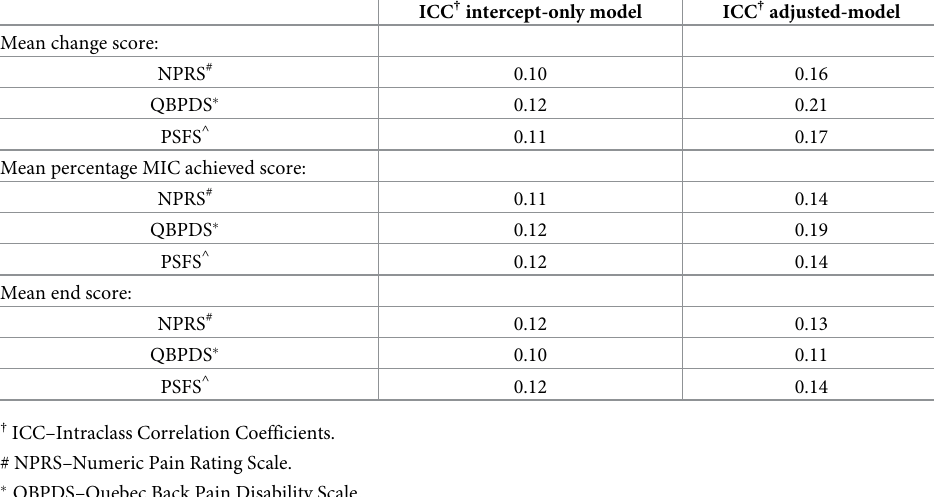
Table 7. The intraclass correlation coefficients for the intercept-only model and adjusted model on the mean change-score, the mean percentage of MIC achieved-score and the mean end score of all selected PROMs. ICC † intercept-only model Mean change